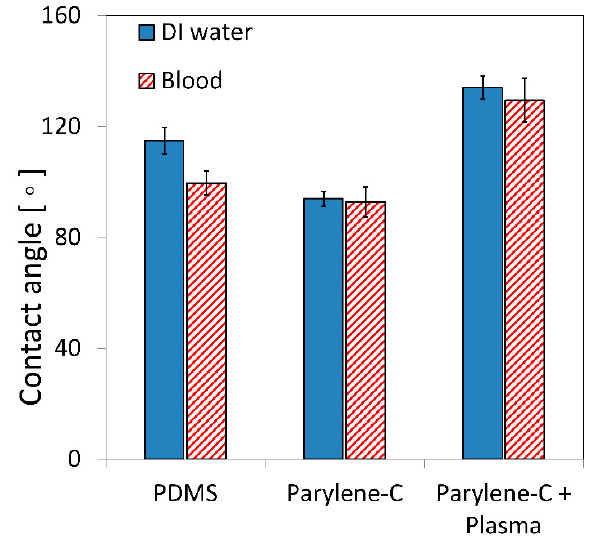
Figure 1. Measured contact angle for DI water and pig whole blood on Polydimethylsiloxane (PDMS) and Parylene-C before and after plasma treatment. The error bars represent the standard deviation between three different measurements.